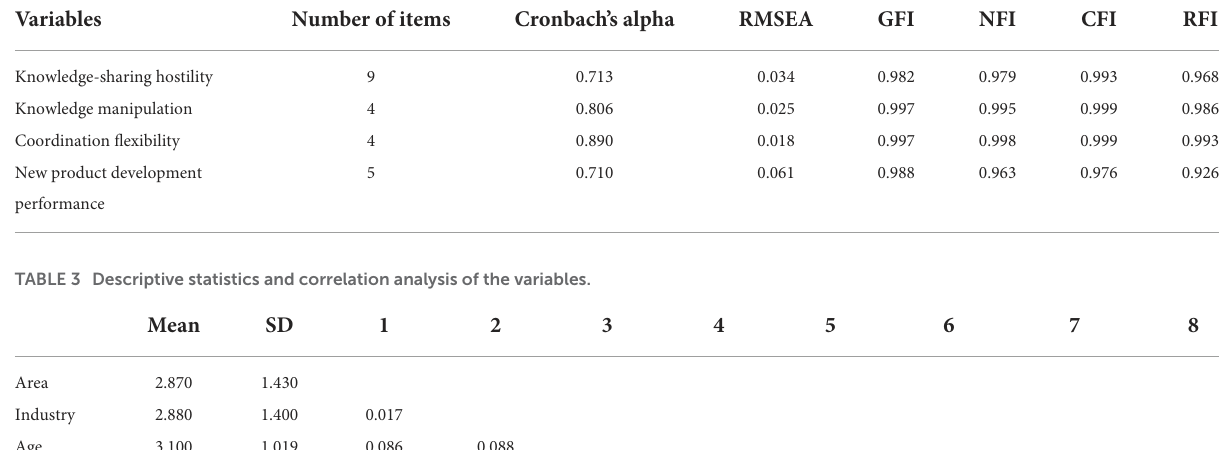
TABLE 2 Reliability and validity of the measurement scale.